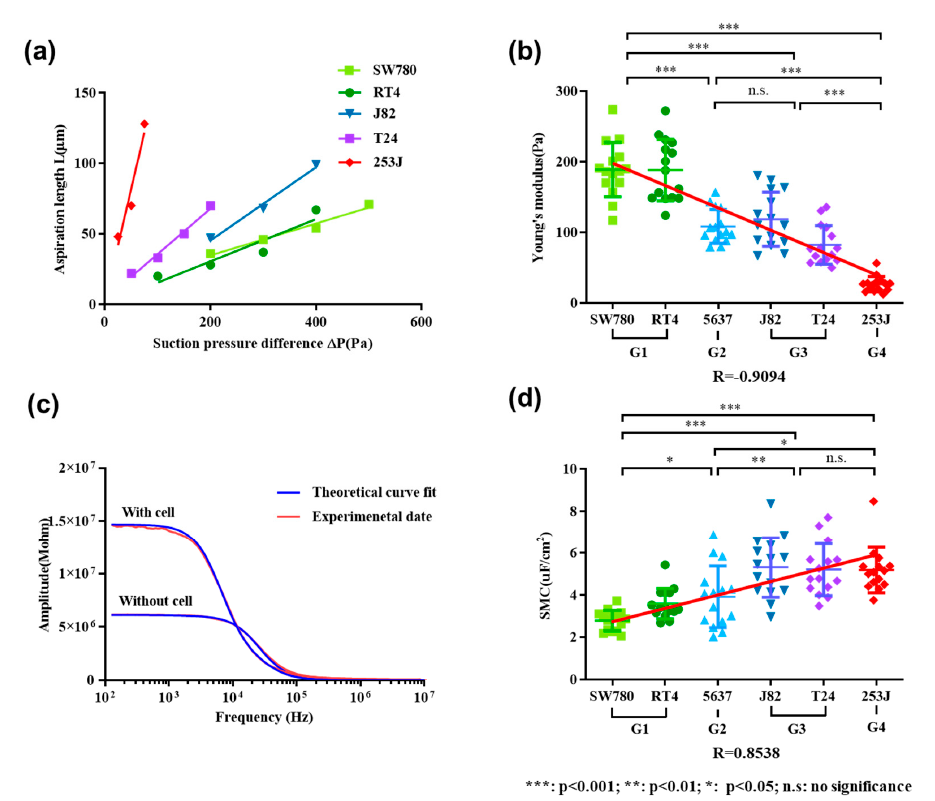
Figure 3. The Young’s modulus is negatively linearly correlated with bladder cancer grades, while specific membrane capacitance (SMC) showed a positive linear correlation. ( a ) Diagram of adsorption pressure relative to cell length; ( b ) Young’s modulus of six types of cell lines; ( c ) impedance spectra in no ‐ load and cellular states of T24; ( d ) SMC value of six types of cell lines.